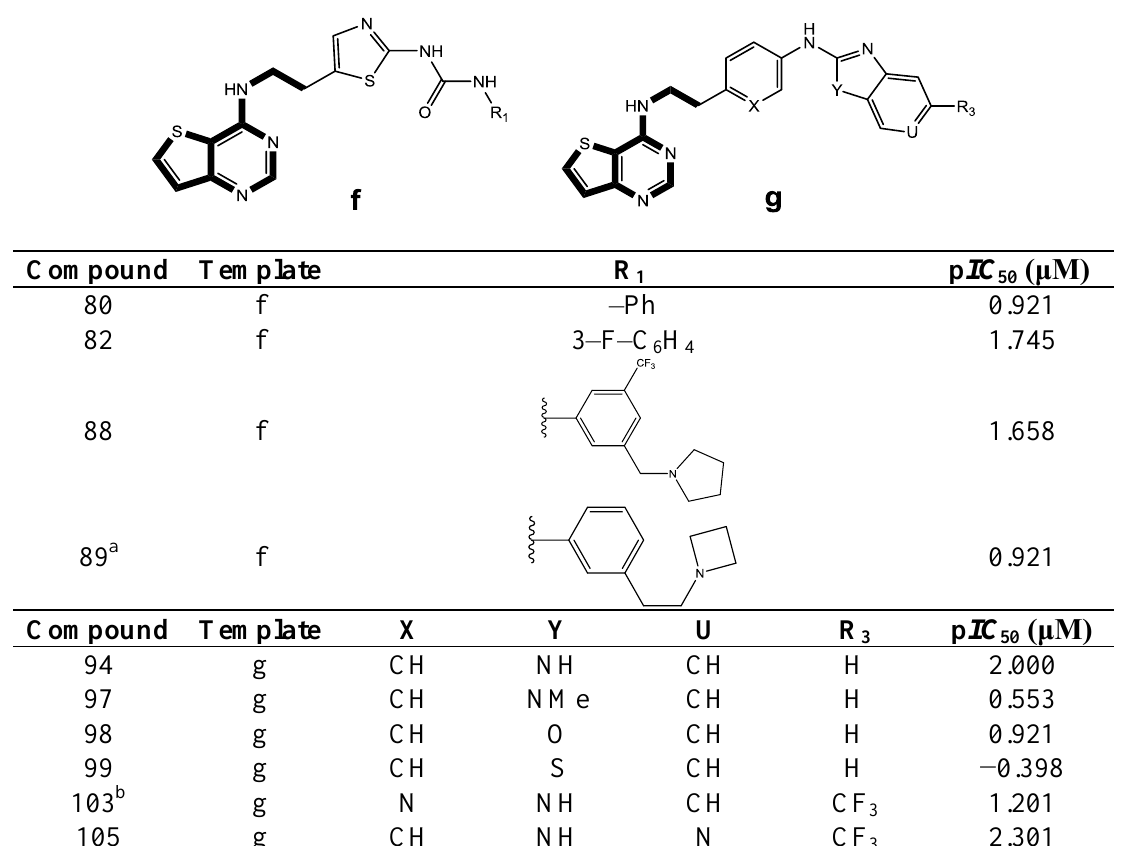
Table 3. Representative skeletons and molecular structures of sns-314 derivatives and their binding affinity values (p IC 50